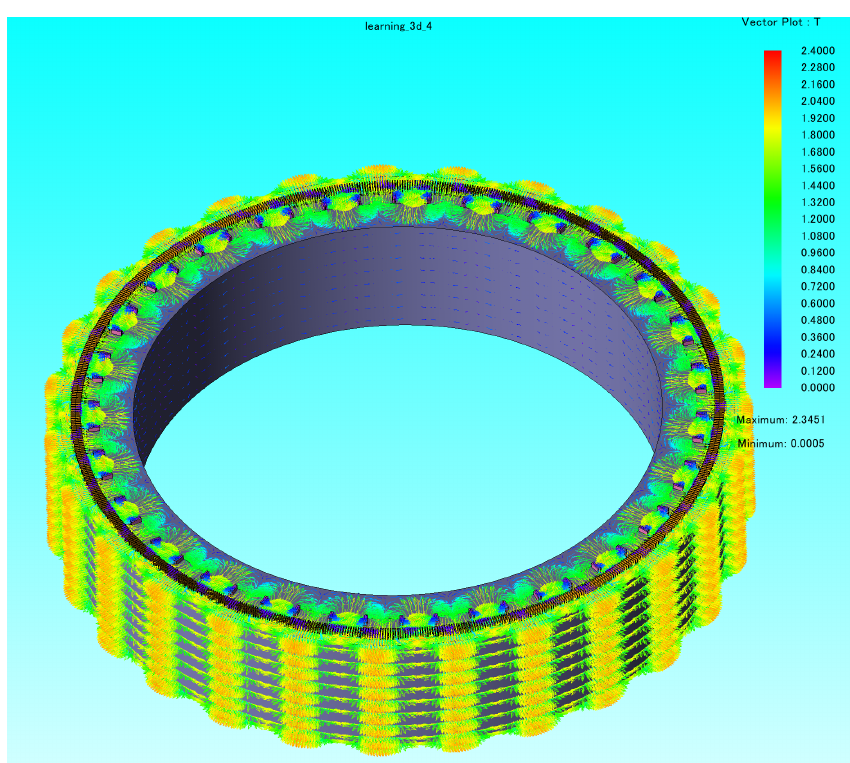
Figure 9. Vector magnetic potential map.